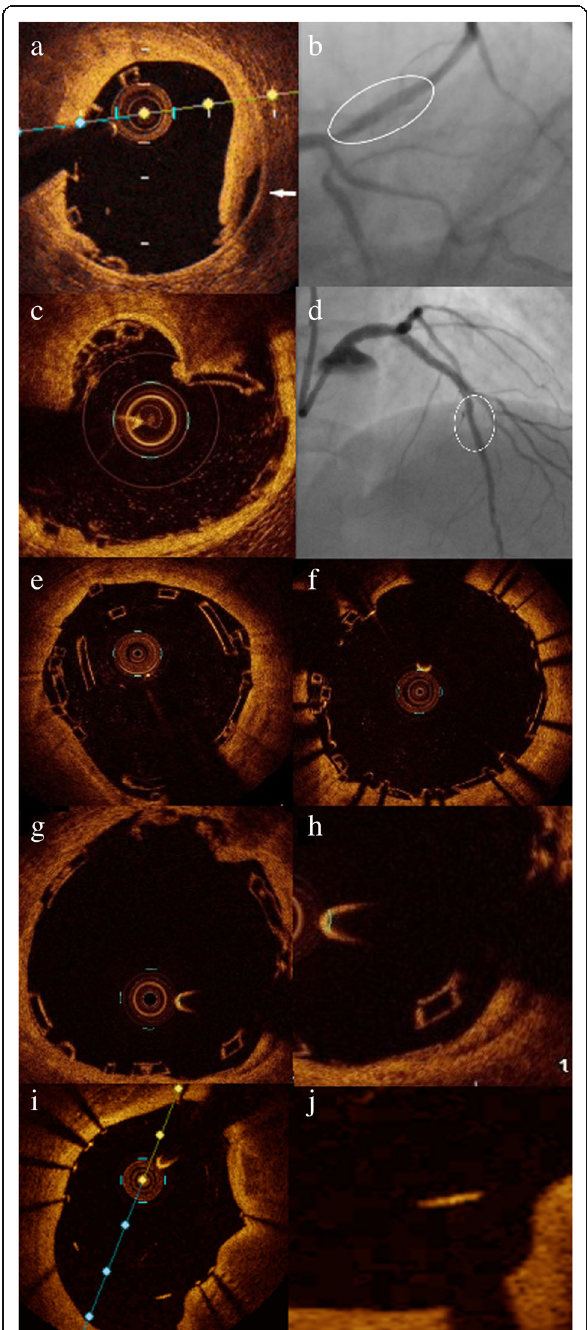
Fig. 1 OCT detected BRS and DES complications. a OCT image of intimal dissection at the edge of Absorb scaffold (arrow), b PA caudal view of the same scaffold implanted in proximal LAD (oval shape) in which edge dissection could not be identified, c OCT image of calcium spike inducing scaffold fracture with loss of the expected scaffold circularity, d PA cranial view of the same scaffold implanted in mid LAD (oval shape) without evidence of fracture, e OCT image of scaffold fracture in the form of overriding contiguous struts post culotte bifurcation stenting, f post successful stenting of the same scaffold using DES, g OCT showing malapposed scaffold struts, h magnified picture showing scaffold struts clearly separated from the vessel wall, i OCT picture showing metallic struts malapposition with posterior dropout, and j magnified picture showing that the axial distance between the strut ’ s surface and the luminal surface exceeds the strut thickness in the malapposing